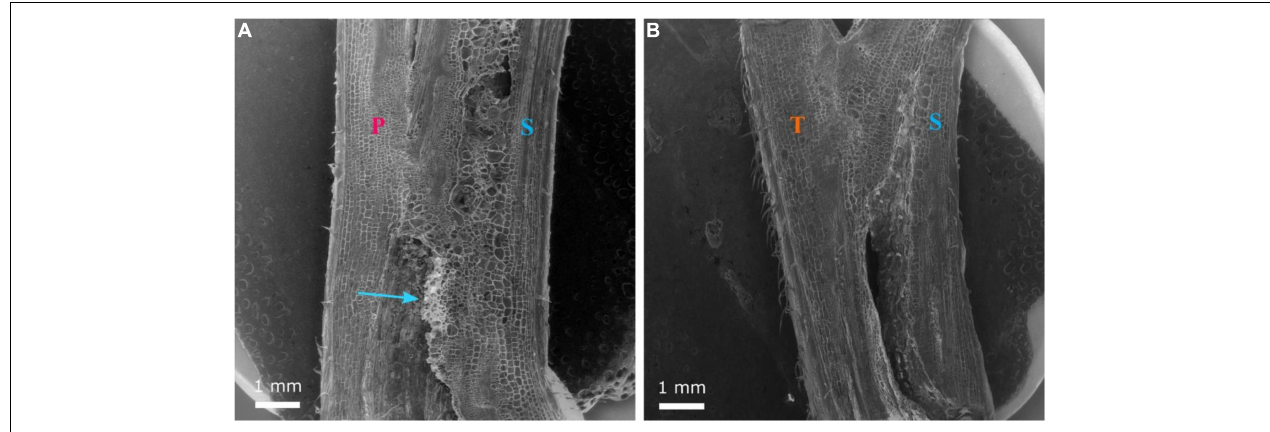
FIGURE 5 | Longitudinal section of the graft union between watermelon cultivar ‘Secretariat’ (S) grafted onto rootstock ‘Pelop’ (P; A ) and ‘Tetsukabuto’ (T; B ) at 11 days after grafting. Parenchymatous callus has formed at the graft interface and the blue arrow (A) indicates a non-uniform layer of sugar